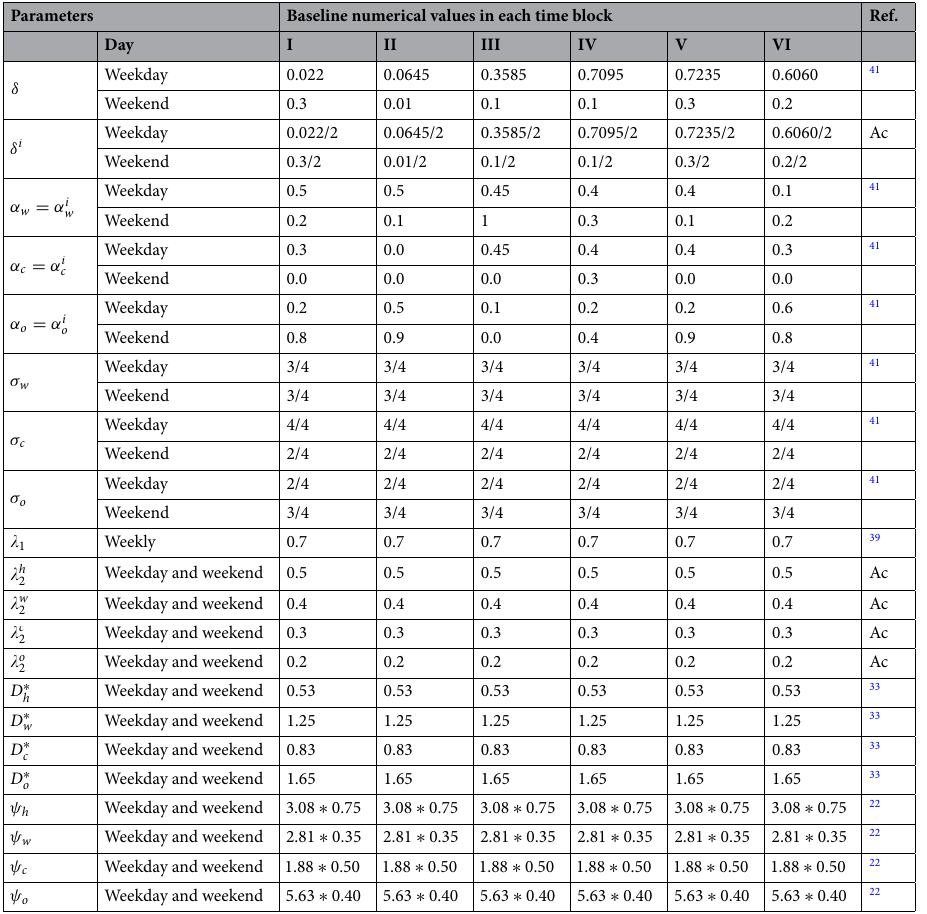
Table 4. Baseline numerical values occupied in the numerical simulations by blocks during the week and on weekends. Ac author